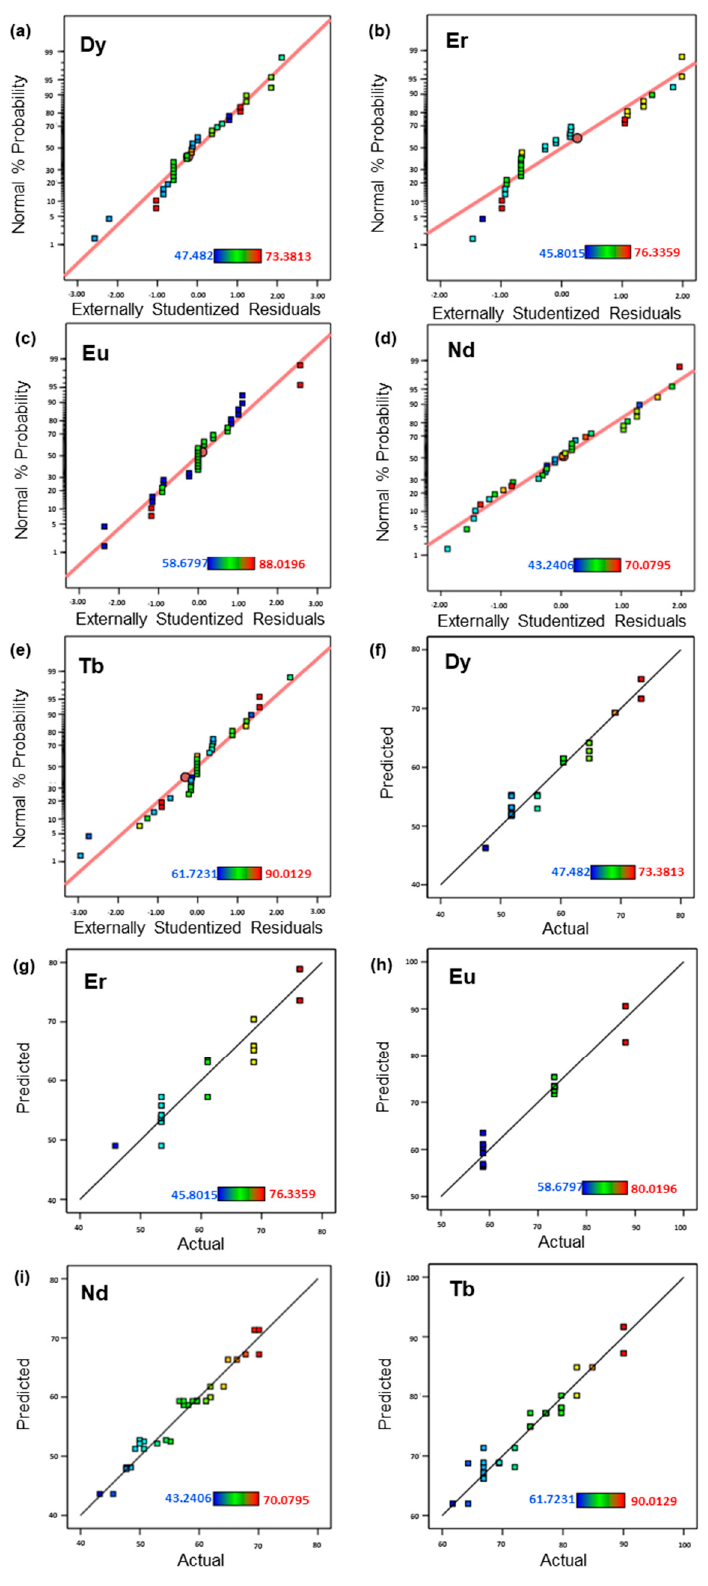
Figure 7. Diagnostic plots.